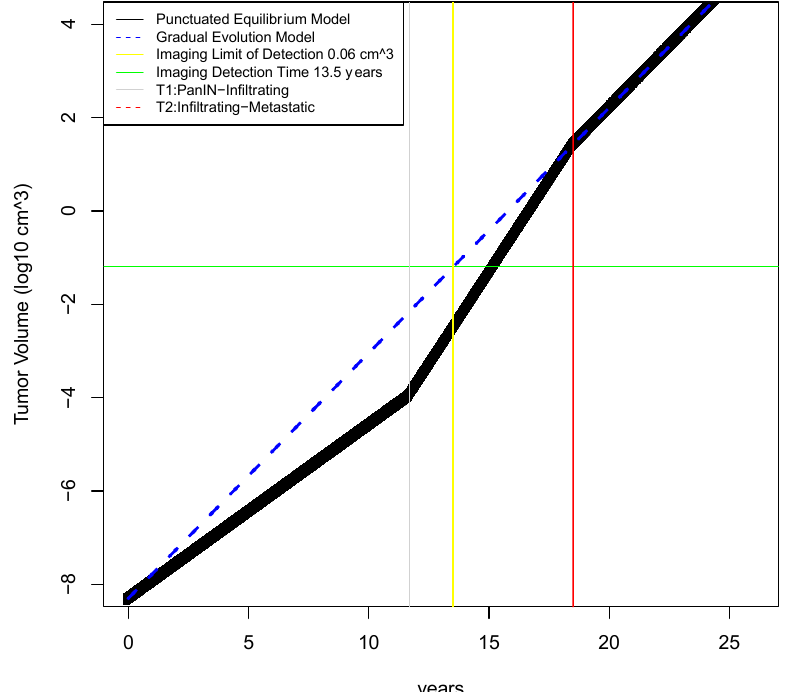
Figure 2. Timecourse of tumor growth in gradual evolution vs punctuated equilibrium models. In the gradual evolution model, tumor growth is assumed to be exponential from the single founder clone all through the disease course. In the punctuated equilibrium model, the tumor is assumed to exhibit exponential growth in 3 phases, with the middle phase representing catastrophic genomic events that rapidly accelerate growth. Medical imaging is assumed to have a lower limit of detection of 5 mm 3 (2.125 mm diameter) which corresponds to 13.5 years of tumor growth in the gradual evolution